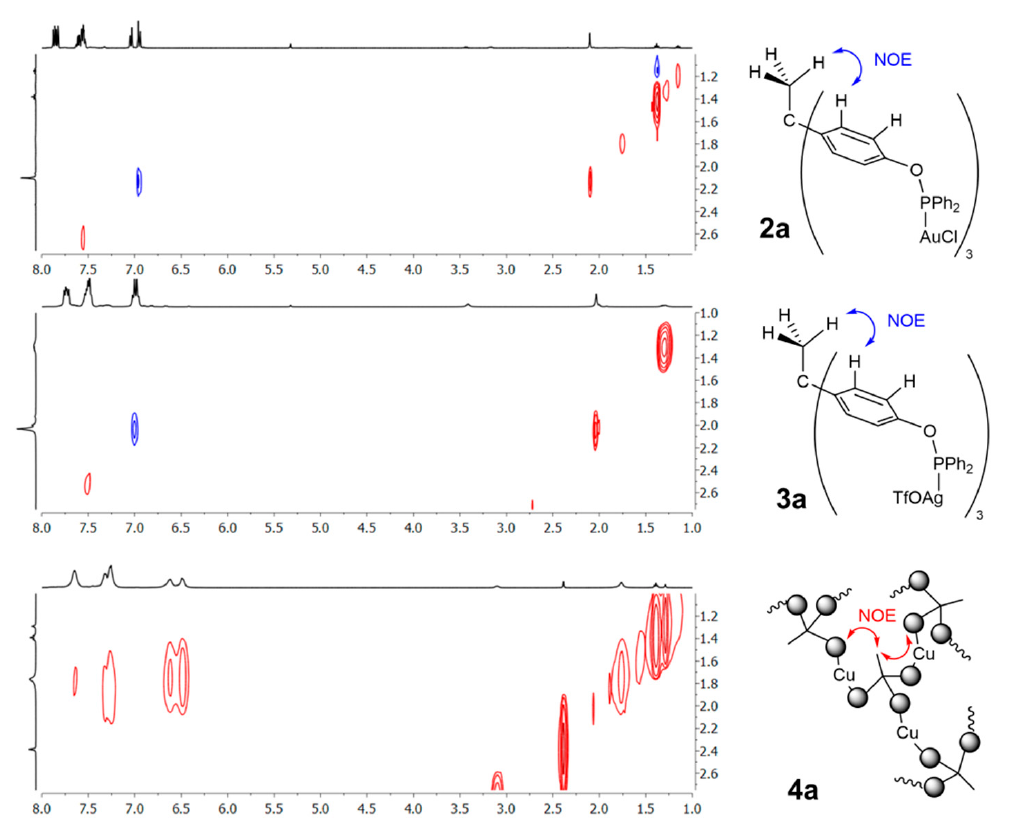
Figure 2. 1 H, 1 H NOESY experiments of compounds 2a , 3a, and 4a . Grey balls in 4a represent C 6 H 4 -O-PPh 2 moieties.